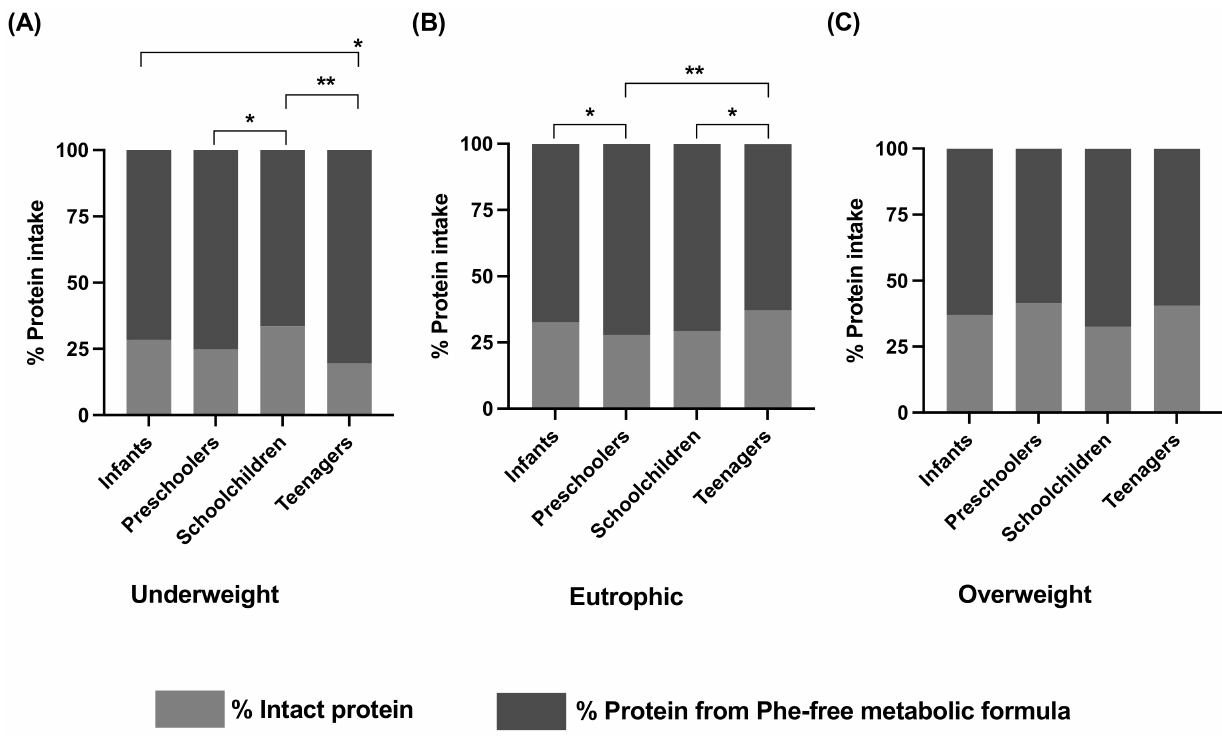
Figure 4. Percentage of protein intake of PKU patients classified by age and nutritional status. The percentage of protein intake from natural protein and from PHE-free nutritional formula was calculated from patients’ dietary recalls. ( A ) Percentage of protein intake from Phe-free metabolic formula and intact protein in underweight patients. ( B ) Percentage of protein intake from Phe-free metabolic formula and intact protein in eutrophic patients. ( C ) Percentage of protein intake from Phe-free metabolic formula and intact protein in overweight patients. Statistical differences in the percentage of protein intake from PHE-free nutritional formula between the studied age groups are shown. A p -value < 0.05 was considered statistically significant (* p < 0.05, ** p < 0.01. Nutritional status was assessed according to the BMI Z-Score. Age groups: infants (<2 years), preschoolers (2 years to <6 years), schoolchildren (6 to <11 years) and teenagers (11 to 18